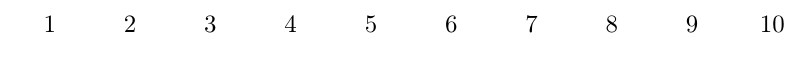
Table 1. Correlations for humor use with organization internal actors (ingroup).